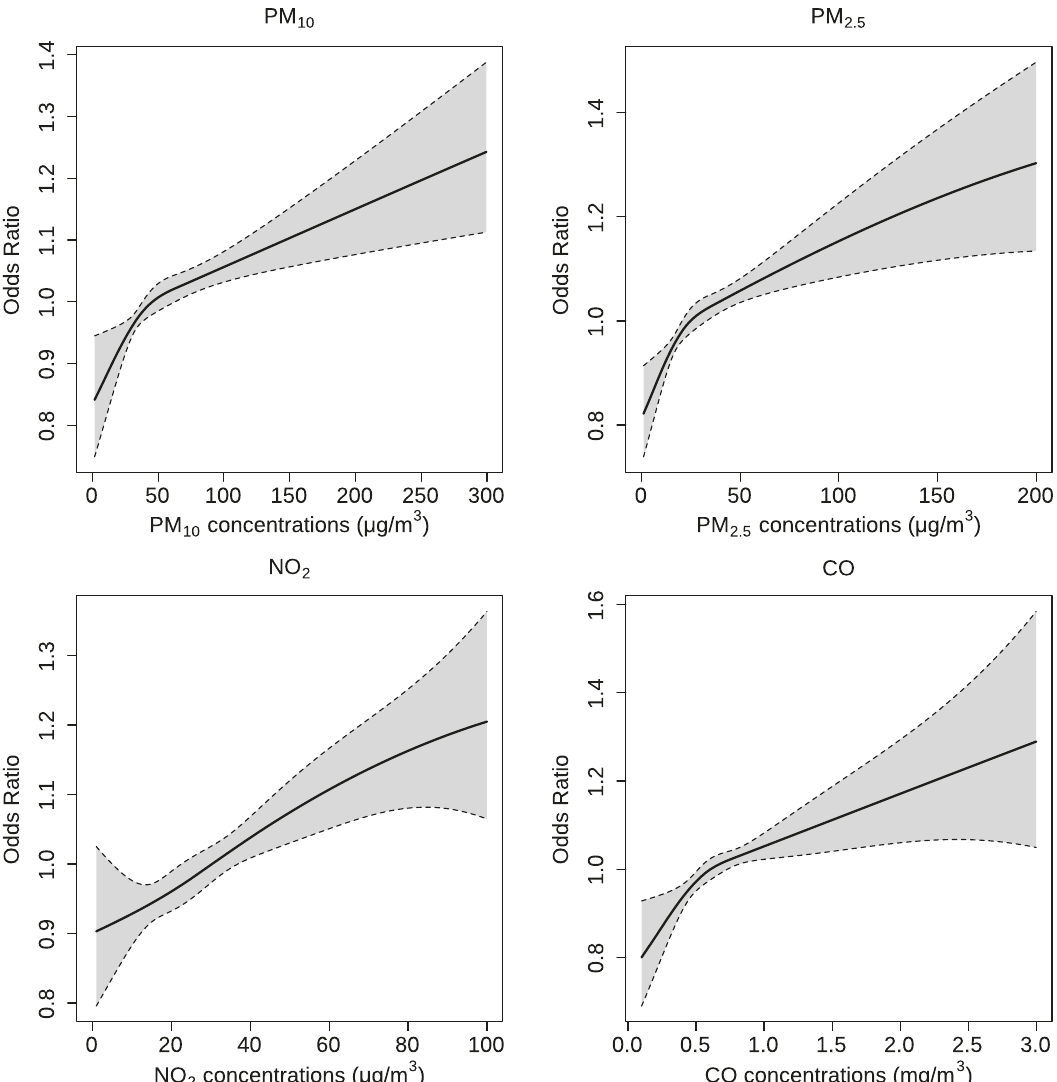
Fig. 2 Exposure-response relationship curves between air pollutant concentrations and atrial fi brillation. The associations were presented as the odds ratio of atrial fi brillation associated with each unit increase in air pollutant concentrations at lag 18 – 24 h. The black lines were mean estimates and the shaded areas were 95% con fi dence intervals. Abbreviations as in Table